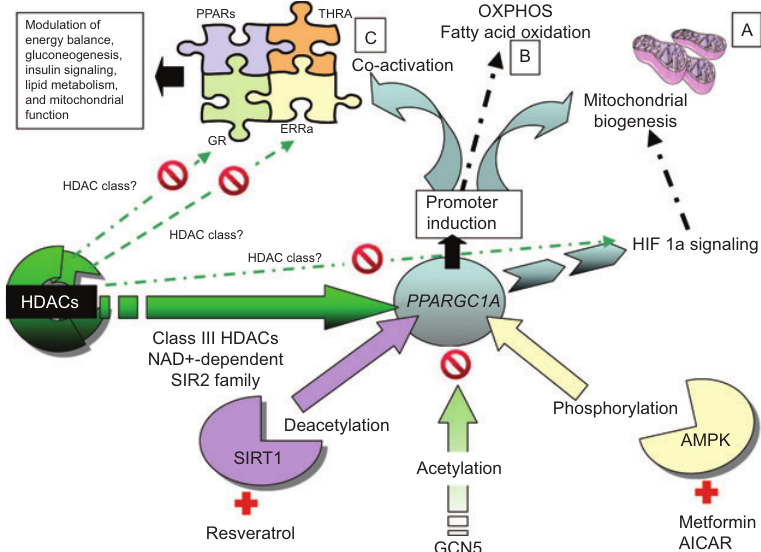
Figure 3 Biological rationale of targeting epigenetics by focusing on PPARGC1A : modulation of the acetylation-deacetylation switch. Induction of the PPARGC1A promoter results in modulation of mitochondrial biogenesis, OXPHOS activity and coactivation of nuclear recep- tors involved in the regulation of metabolic functions (A, B and C). But the activity of the PPARGC1A promoter can be epigenetically regulated resulting in either repression or activation of gene transcription. For example, PPARGC1A is a putative target for epigenetically active drugs by the modulation of the acetylation-deacetylation switch mediated by Class III HDACs of the NAD + -dependent SIR family, which can repress the promoter activity. This repression signifi cantly impacts on the transcriptional machinery of several other genes modulated by PPARGC1A , for example, glucocorticoid receptor, ERR α and HIF1 α that also results in modulation of the mitochondrial biogenesis. PPARGC1A is, in addi- tion, directly acetylated by another acetyltransferase enzyme, such as General Control Nonderepressible 5 (GCN5), a process that also results in a transcriptional repression of the PPARGC1A . On the contrary, post-translational modifi cations can positively regulate the activity of the PPARGC1A protein, either by direct phosphorylation mediated by AMPK or by deacetylation mediated by NAD-dependent deacetylase SIRT1. Some drugs and natural compounds can activate these two post-translational modifi cations, such as metformin and AICAR or resveratrol, respectively. GR , glucocorticoid receptor; THRA , thyroid hormone receptor α ; PPARS , peroxisome proliferator-activated receptors; ERR α , estrogen-related receptor α ; PPARGC1A , peroxisome proliferator-activated receptor γ , coactivator 1 α ; HIF1 α , hypoxia inducible factor 1, α subunit (basic helix-loop-helix transcription factor); SIRT1 , sirtuin 1; AMPK, 5 ′ AMP-activated protein kinase; OXPHOS, oxidative